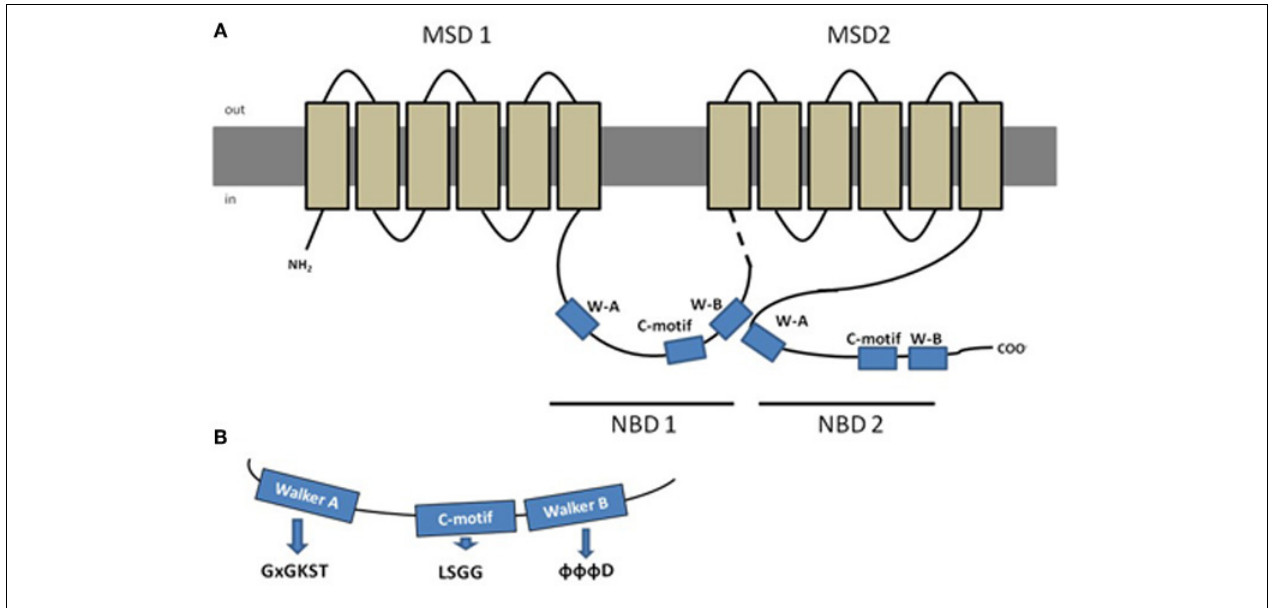
FIGURE 1 | Schematic representation of a typical ABC protein and characteristic amino acid sequences found in Nucleotide Binding Domains (NBDs). (A) Lipidic bilayer is shown in gray, membrane spanning domains (MSDs) in light brown and nucleotide binding domains (NBDs) in